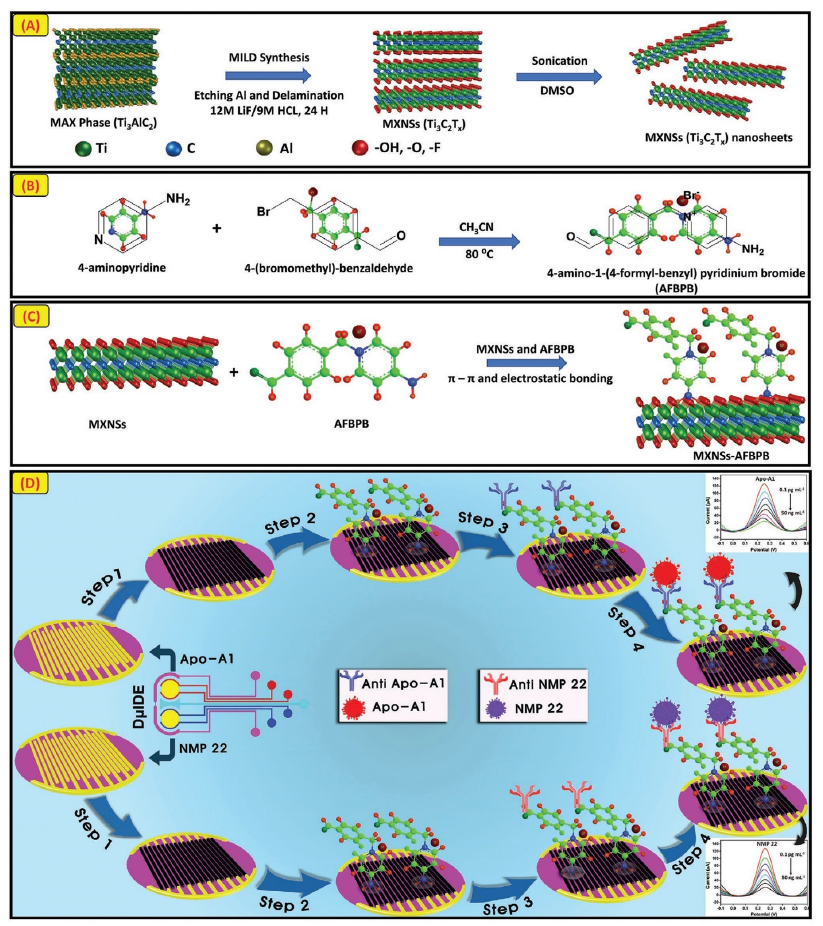
Figure 10. ( A ) Conceptual illustration of the synthesis of MXNSs-Ti 3 C 2 Tx. ( B ) A diagram illustrating the production of the multipurpose 4-amino-1-(4-formylbenzyl) pyridinium bromide (AFBPB) TSIL. ( C ) AFBPB is used in the MXNS functionalization as shown in the schematic. ( D ) A diagram outlining the procedures for developing the immunosensor for detecting NMP 22 and Apo-A1. Reproduced with permission from [96].